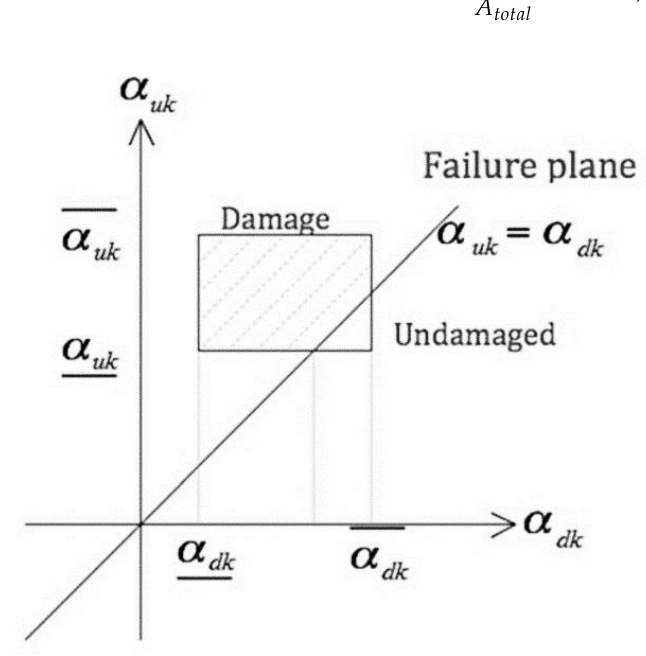
Figure 2. Space for damaged and undamaged